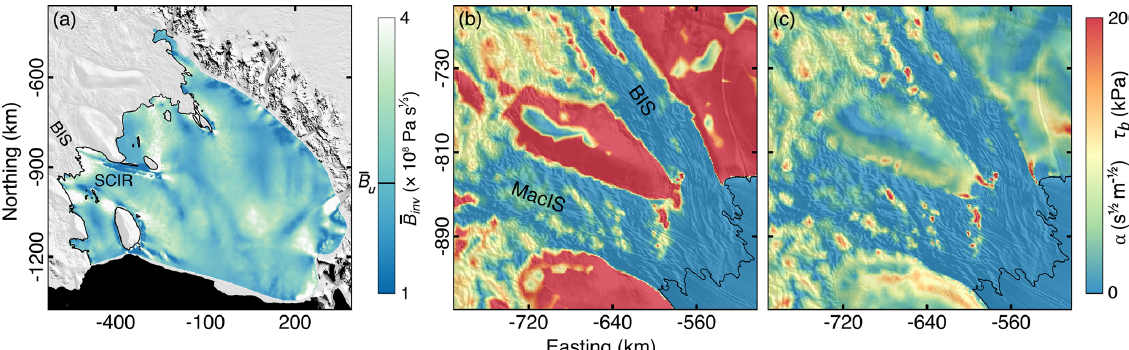
Figure 2. Panel (a) shows the inverse rate factor B inv in the floating part of the model domain. The value of uniform B u is shown in the colour bar of panel (a) . Panels (b) and (c) focus on MacIS and BIS, showing the friction coefficient α and corresponding basal drag τ b = − α 2 N u b . The grounding line is the observed position from Bindschadler et al.